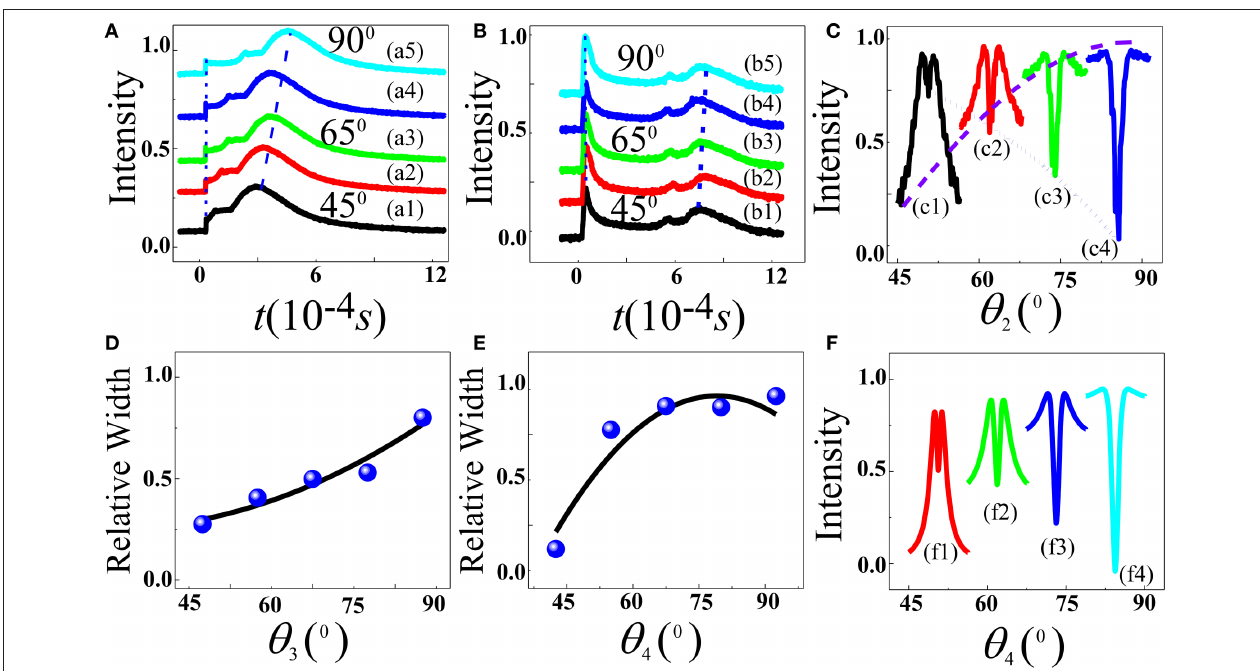
FIGURE 4 | (A,B) are V-type level system, the intensity of composite FL signal at 1 2 = 0 in time domain. (A) By changing E b polarization from 45 ◦ to 60 ◦ to 75 ◦ , and then to 90 ◦ , respectively, by QWP while scanning E a . (B) Similar as (A) but using HWP. (C) Shows intensity of FL spectral signals by changing E b polarization by HWP from 45 ◦ to 60 ◦ to 75 ◦ , and then to 90 ◦ , respectively, while scanning E a . (D,E) Correspond the AT-splitting distance of (A,B) , respectively. (F) Theoretical prediction of (C) .